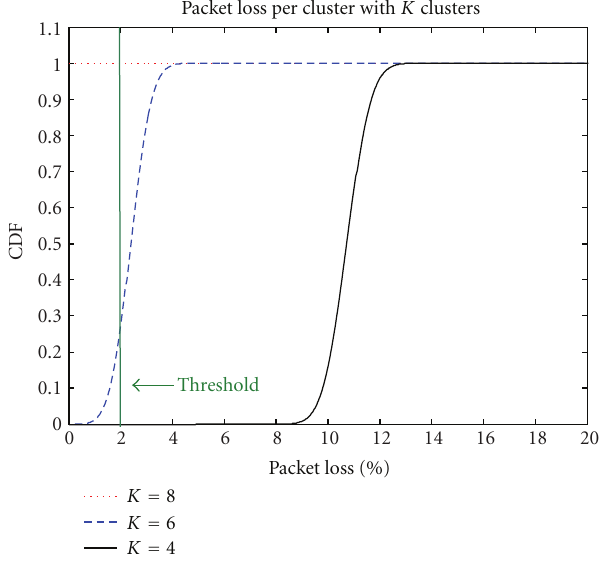
Figure 3: The e ff ect of the number of clusters on the CDF of the percentage of number of packet losses. The approximate K min is eight from (2), when r = 100 m, V m = 2m/s, n = 3500, T rq = 10ms, and T P = 200